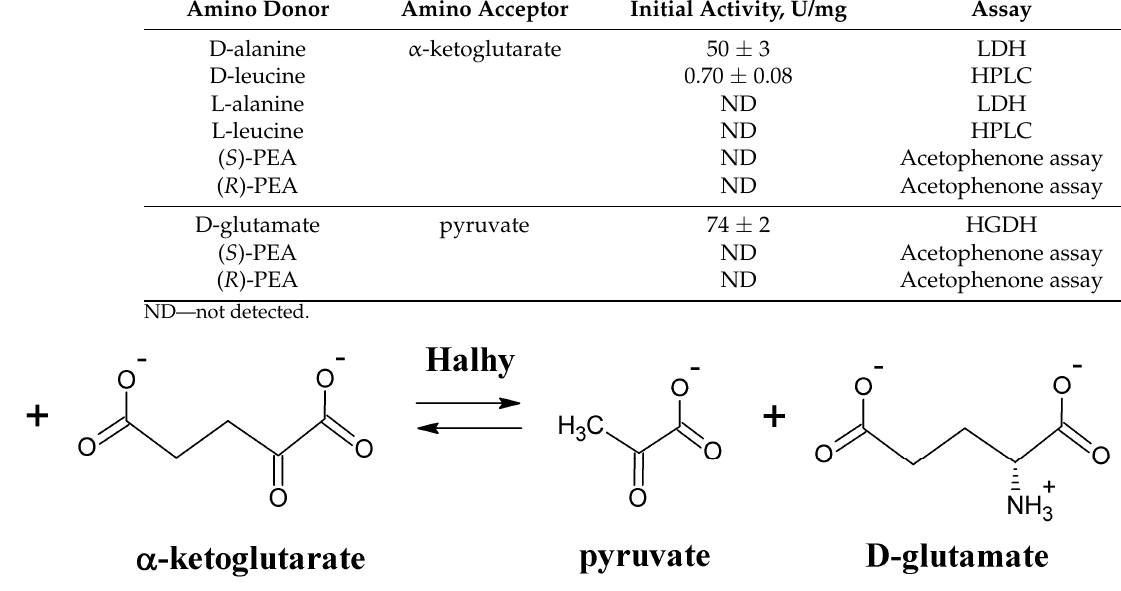
Table 2. The activity of Halhy towards different amino donors in the overall transamination reaction.